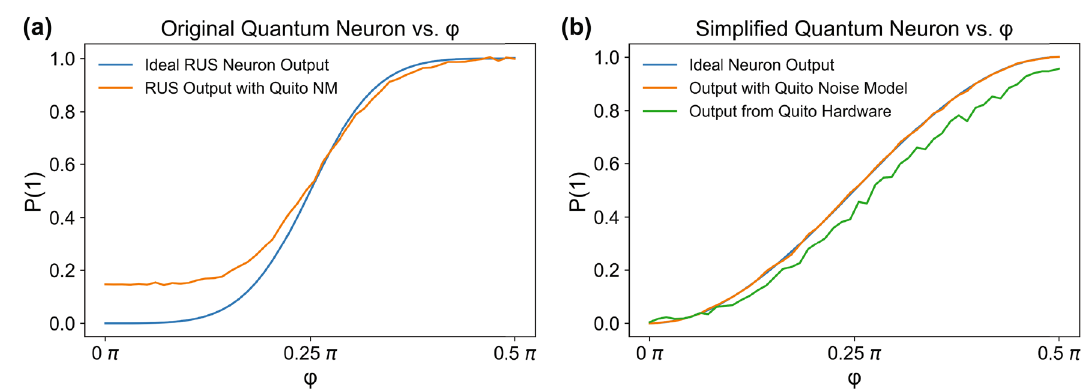
Figure 3. Quantum neuron output. ( a ) Simulation of the output of the neuron designed by Cao et al. 6 based on Repeat-Until-Success (RUS) operation using the ibmq_quito 31,39 noise model. ( b ) Simulation and IBMQ hardware 31,39 results of our simplified quantum neuron compared to the ideal